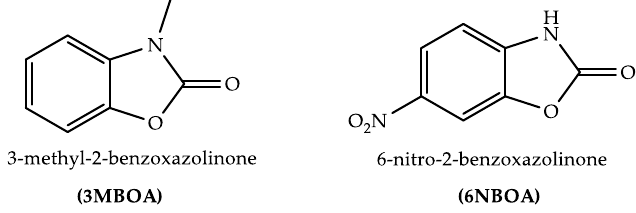
Figure 2. Structural formula of the studied